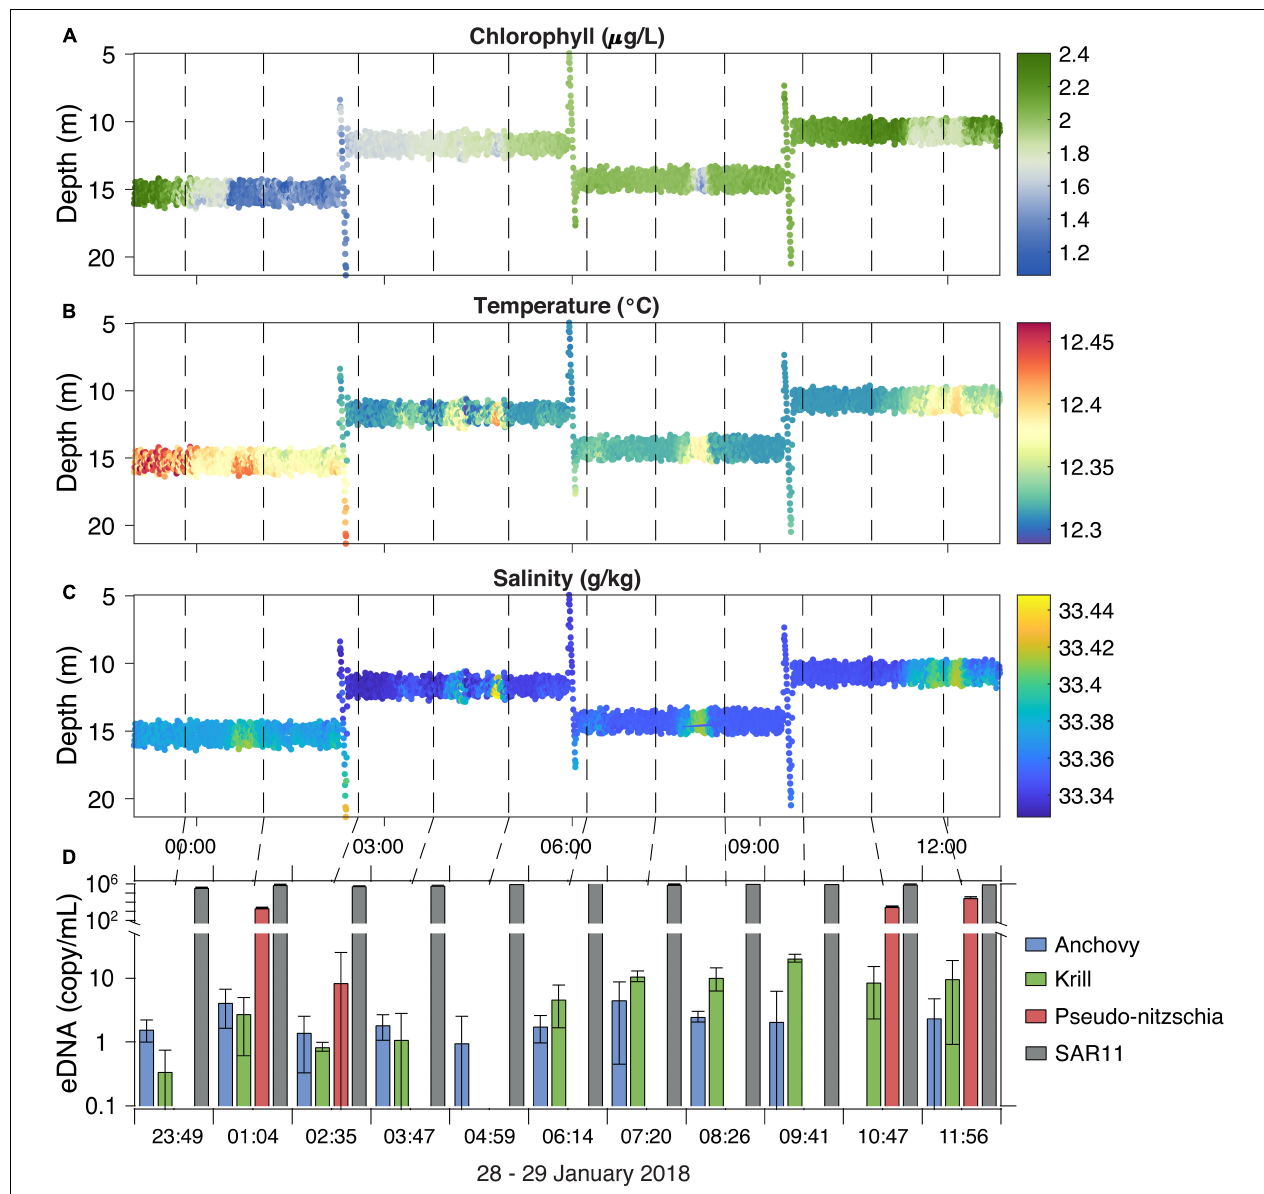
FIGURE 6 | The LRAUV-ESP collected and preserved 11 samples in situ over a 12-h time period in January 2018 (dashed lines) while deployed outside Monterey Bay, CA. LRAUV contextual sensor data includes chlorophyll (A) , temperature (B) , and salinity (C) along with corresponding taxa eDNA concentrations (D) . Error bars represent 95% confidence